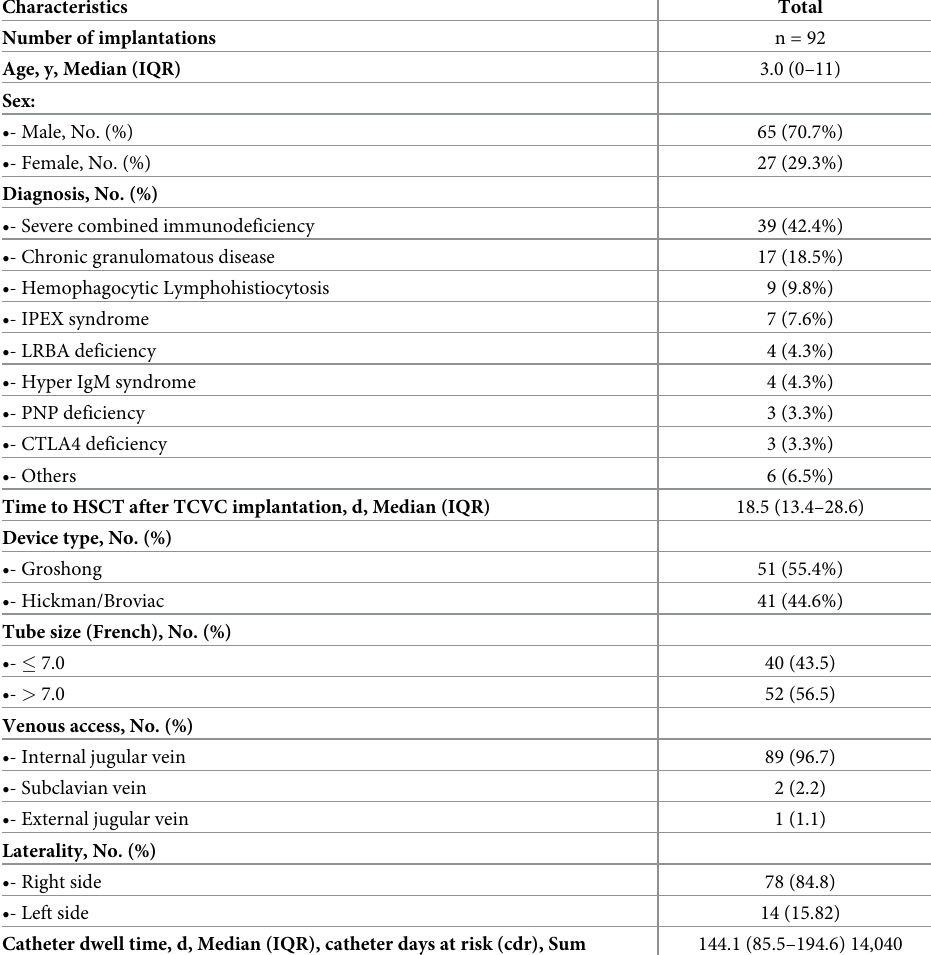
Table 1. Clinical and demographic characteristics of patients receiving 92 TCVC